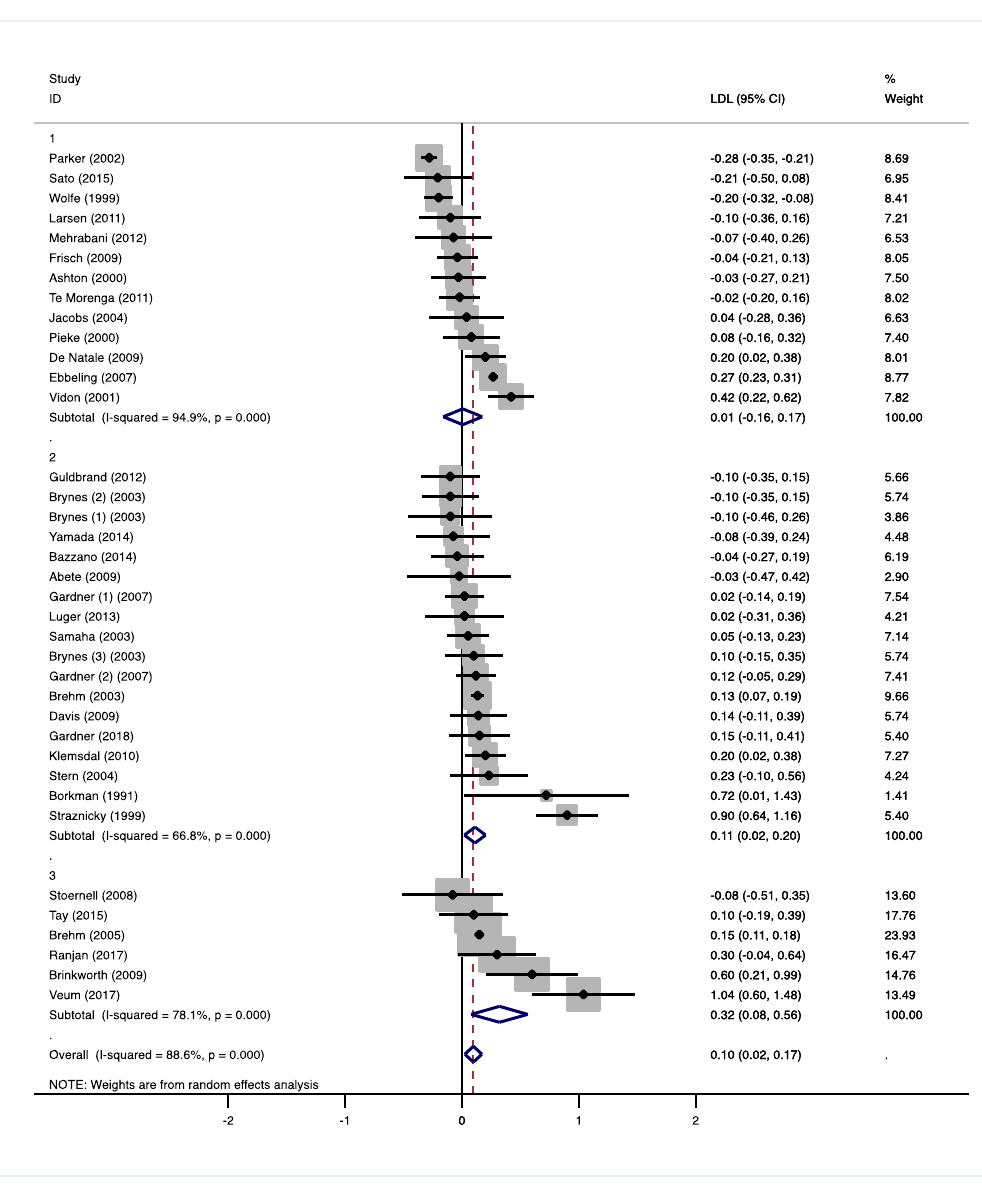
Figure 3. Forest plots of randomized controlled trials that examined the effects of carbohydrate (CHO) restriction on low-density lipoprotein cholesterol (LDL-C) concentrations. Studies were categorized in group 1 (moderate-low CHO, 40–45 E%), group 2 (low CHO, 40–30 E%), and group 3 (very-low CHO, 30–3 E%). Solid squares represent the weight of individual studies and diamonds represent the weighted mean difference (WMD) in LDL-C. Effects were calculated using random-effect meta- analysis. Decreases in LDL-C were significantly larger in the very-low CHO compared to the moderate-low CHO group.